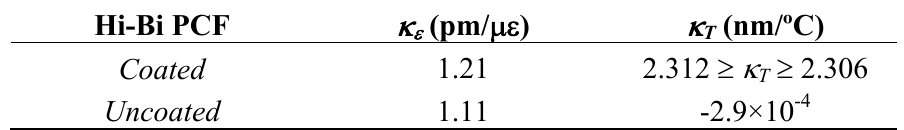
Table 3. Strain and temperature coefficients for the Hi-Bi PCF fiber loop